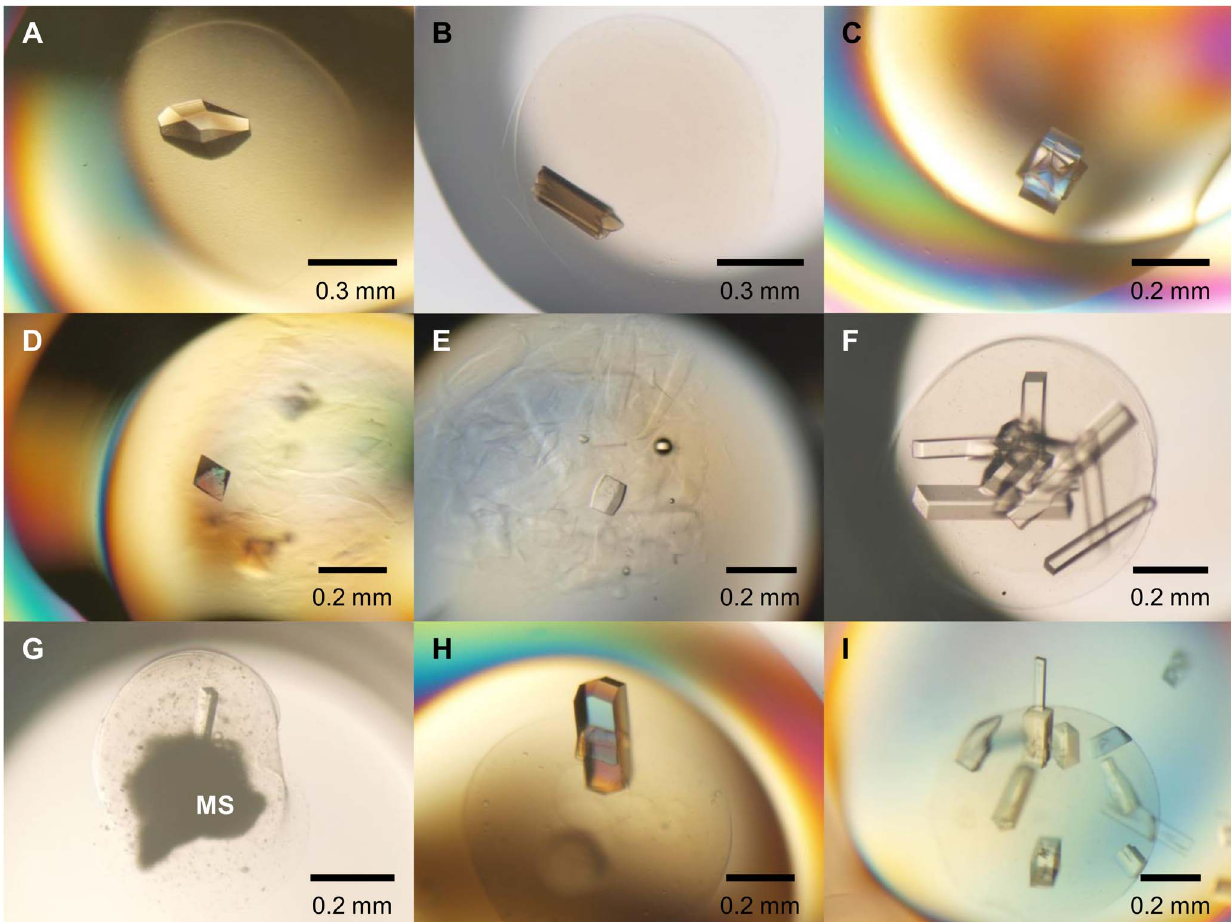
Figure 2. Photographs of protein crystals. (A) lysozyme, (B) catalase, and (C) ID70102 protein for alginate gel beads. (D) ID70067 and (E) ID11492 proteins for k -carrageenan gel beads. Glucose isomerase crystals without MS (F) and with MS (G) in alginate gel beads. Crystals appeared in the gel bead after (A) 1 day, (B) 1–2 days, (C) 2–30 days, (D) 1–7 days, (E) 1 day, (F) 1 day, and (G) 1–4 days. Two proteins, (H) lysozyme and (I) glucose isomerase, crystallized in alginate gel beads after 1 day. Subsequently, additional crystals of both proteins appeared on the gel surfaces after 2–7 days.